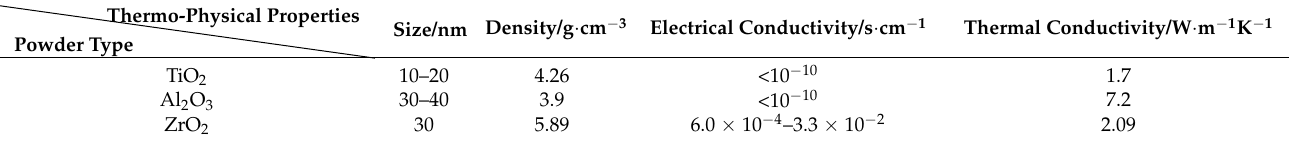
Figure 1. Picture of micro EDM machine tool. Table 1. The thermo-physical properties of the nano particles.